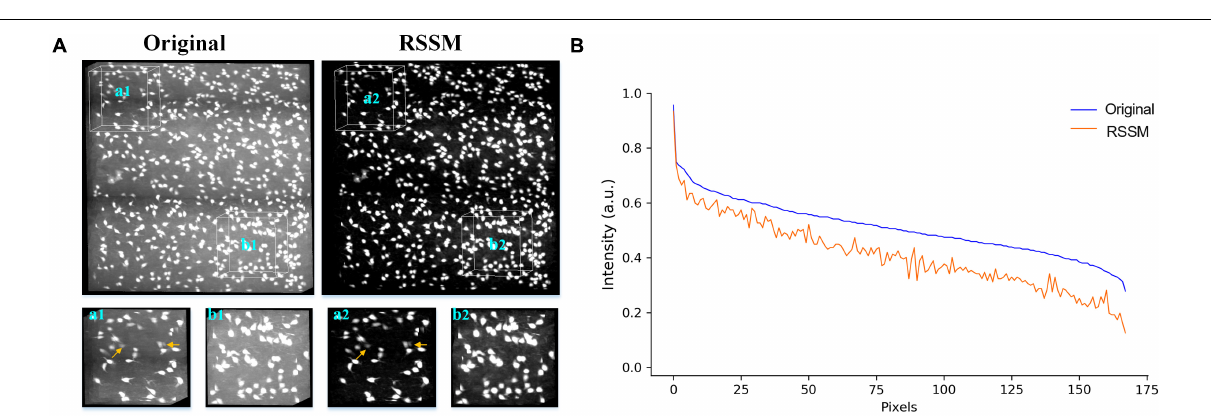
FIGURE 3 | Foreground estimation via RSSM from 3D soma image. (A) Shows a 3D soma image collected using light-sheet microscopy and its corresponding estimated foreground image. Two sub-stacks that contained sparsely and densely distributed somas and inhomogeneous background were showed in the bottom. Somas with weak intensities in a1-a2 are pointed by arrows. (B) Shows the image intensity distribution of all the manual located somas of the original image and the estimated foreground